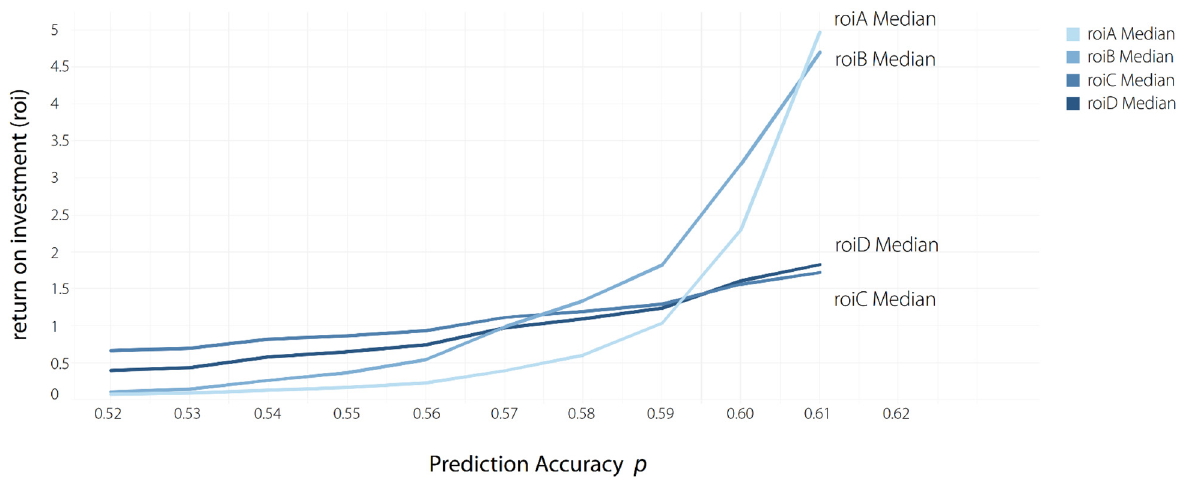
Figure 5. Change in (average of median) roi of the strategies in relation to prediction accuracy 𝑝 on the x ‐ axis.